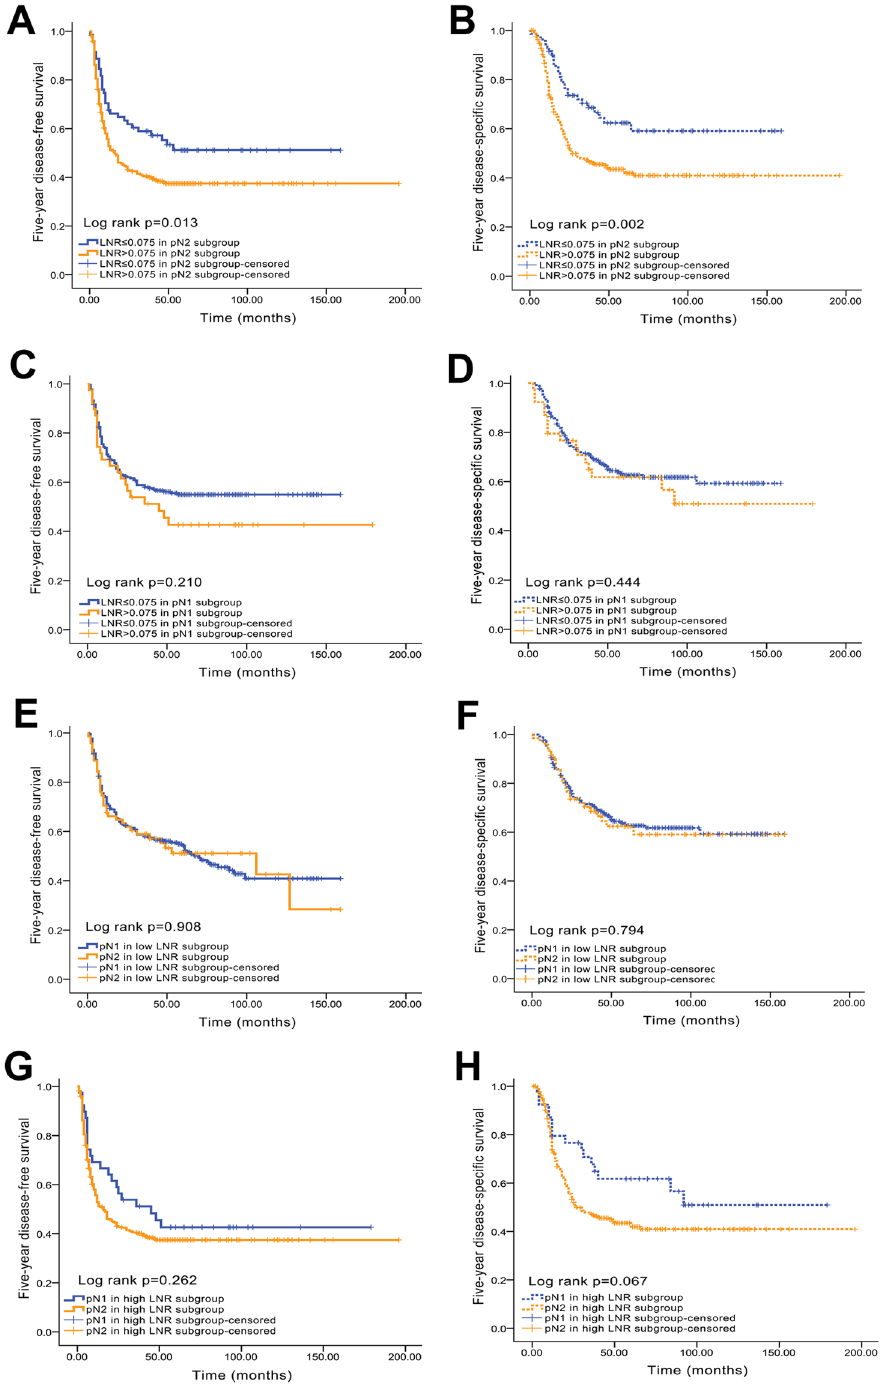
Figure 2. Kaplan-Meier analyses of 5-year DFS and DSS between the LNR and pN stage. ( A ) Five-year DFS curve for the LNR in the pN2 subgroup; ( B ) 5-year DSS curve for the LNR in the pN2 subgroup; ( C ) 5-year DFS curve for the LNR in the pN1 subgroup; ( D ) 5-year DSS curve for the LNR in the pN1 subgroup; ( E ) 5-year DFS curve for pN in the low LNR subgroup; ( F ) 5-year DSS curve for pN in the low LNR subgroup; ( G ) 5-year DFS curve for pN in the high LNR subgroup; ( H ) 5-year DSS curve for pN in the high LNR